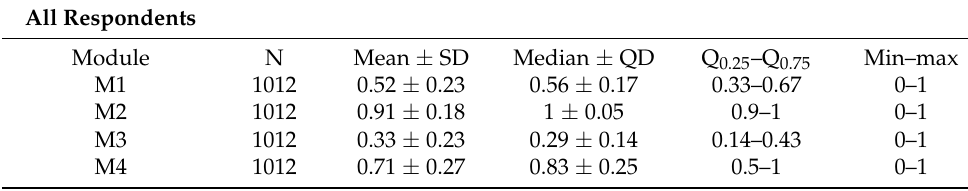
Table 2. Statistics of respondents’ answers for individual